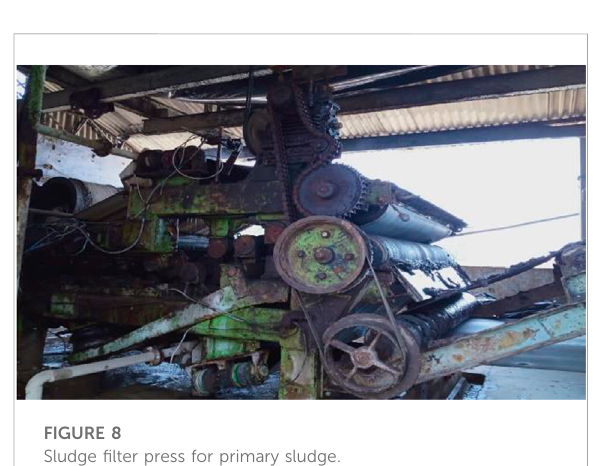
FIGURE 8 Sludge fi lter press for primary sludge.